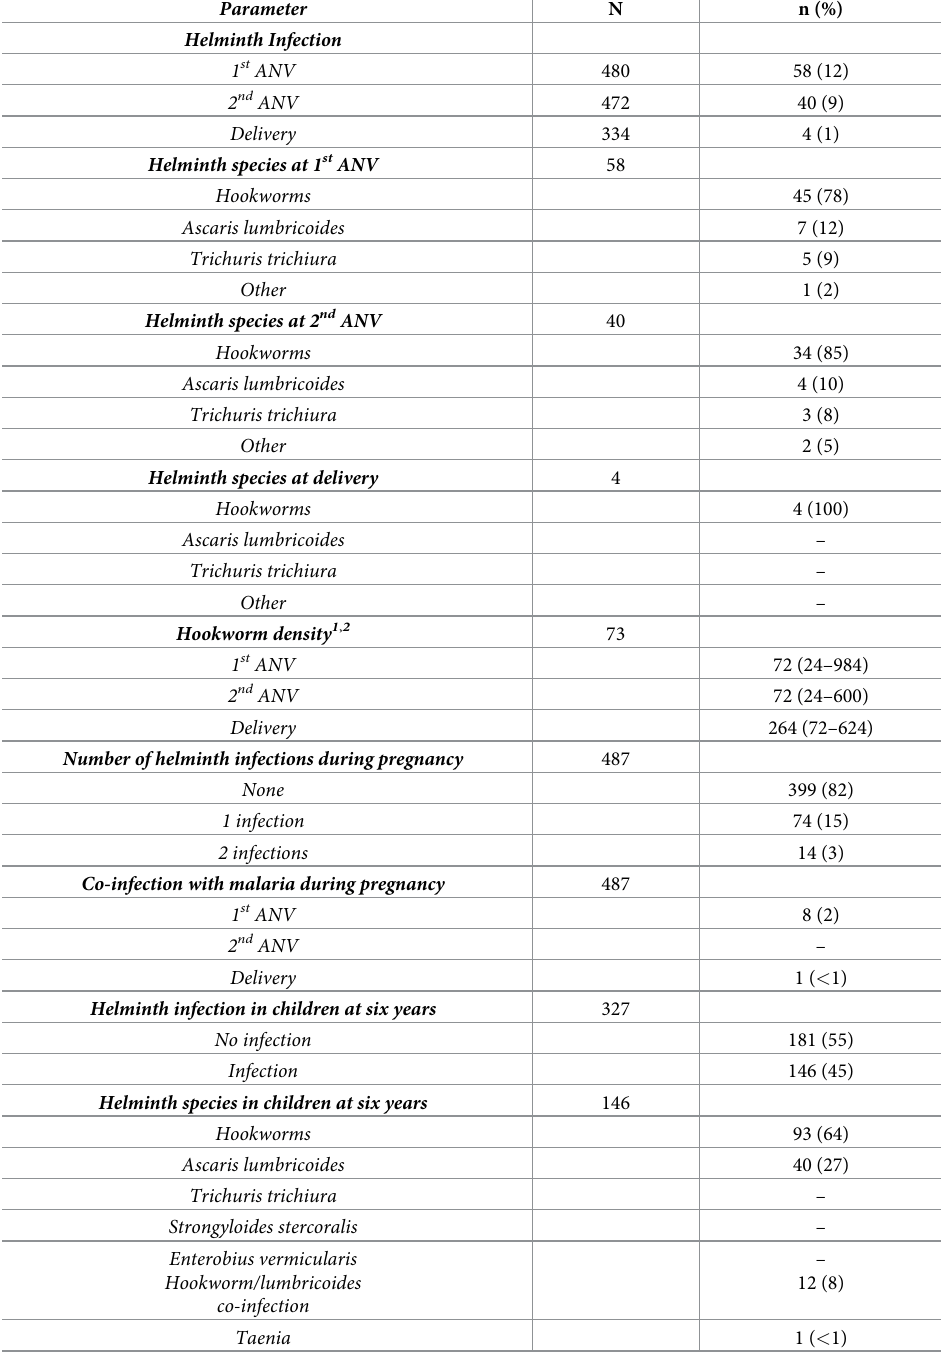
Table 2. Description of infection in women during pregnancy and in children at six